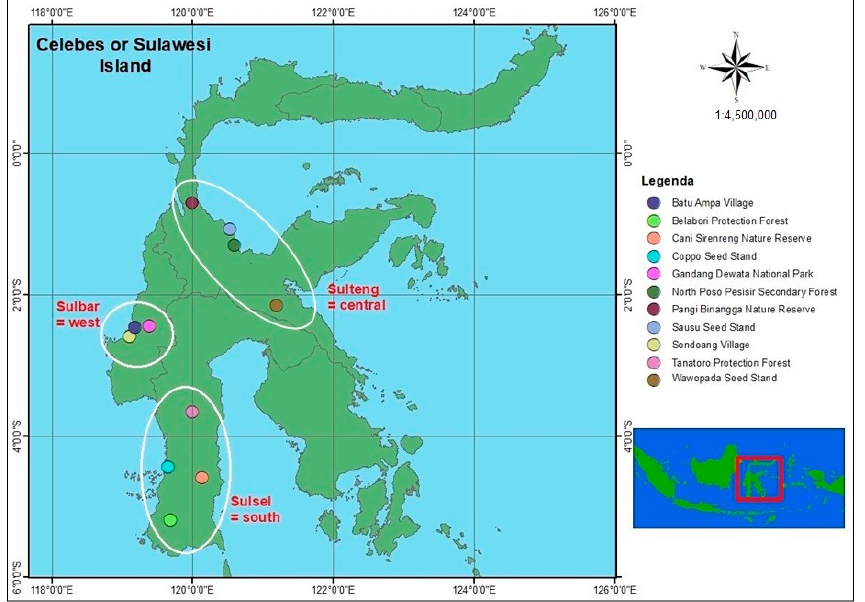
Figure 1. Distribution of the 11 sites where ebony wood samples were collected on Celebes, or Sulawesi, island (Sulsel or South Celebes, Sulbar or West Celebes, and Sulteng or Central Celebes).